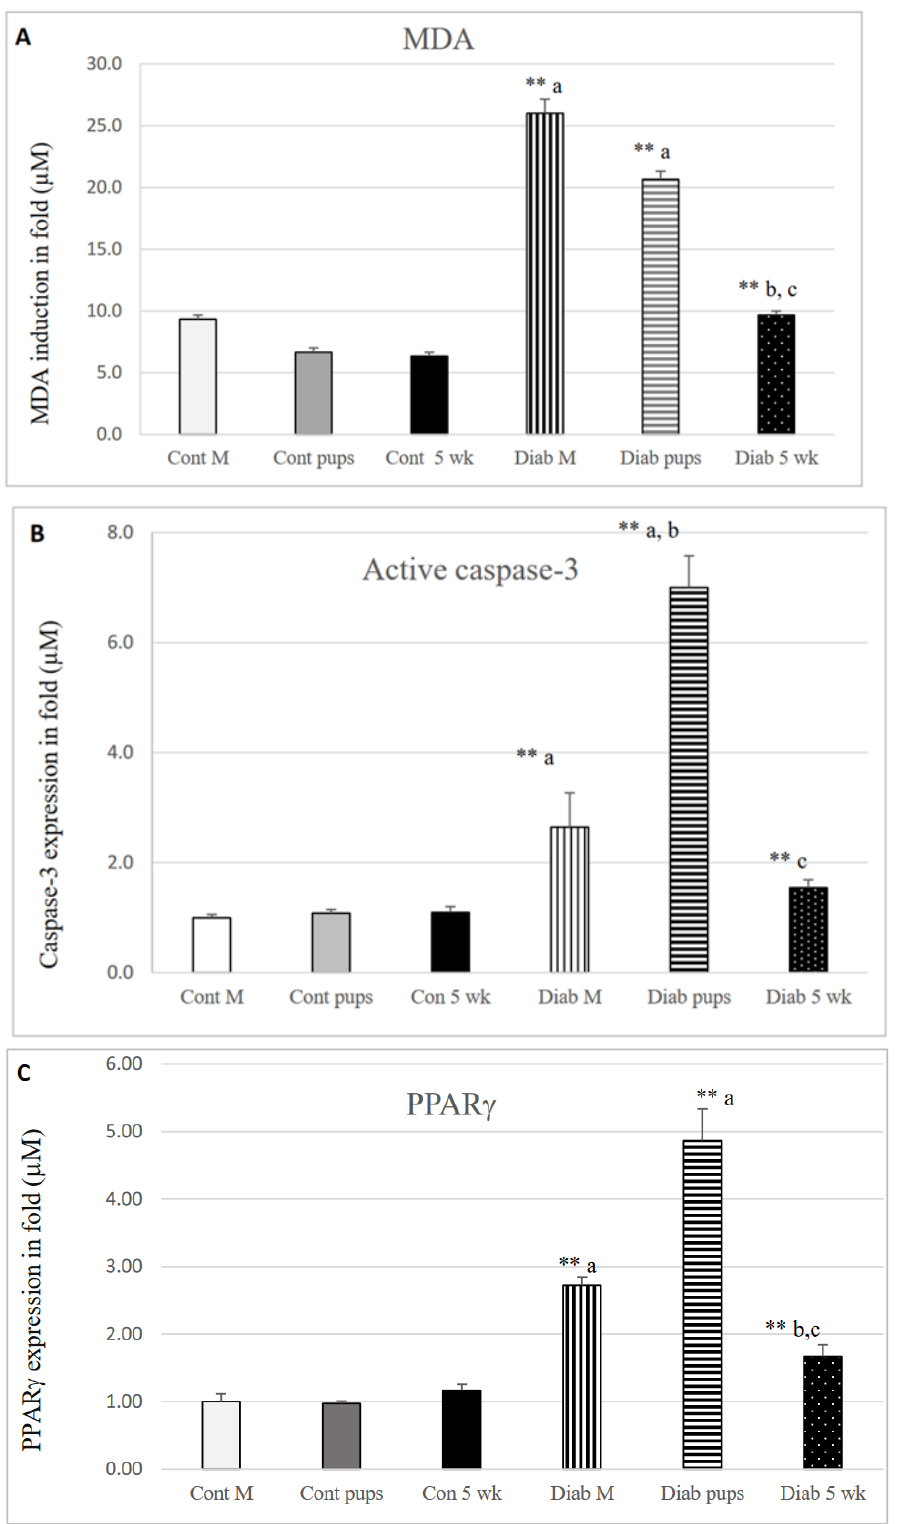
Figure 2. Untreated diabetes during pregnancy induces oxidative stress and increases the rate of apoptosis and the expression levels of PPAR ˠ in brain tissue. p ≤ 0.05 * significant variation, p ≤ 0.01 ** high significant variation. ( A ) versus appropriate control (mothers, newborn pups and 5‑week‑old offspring), ( B ) relative to diabetic mothers, ( C ) relative to diabetic pups. n = 4. 3.7. The Newborn Pups of Untreated Diabetic Mothers Display High Level of Caspase-3 Relative to Other Groups